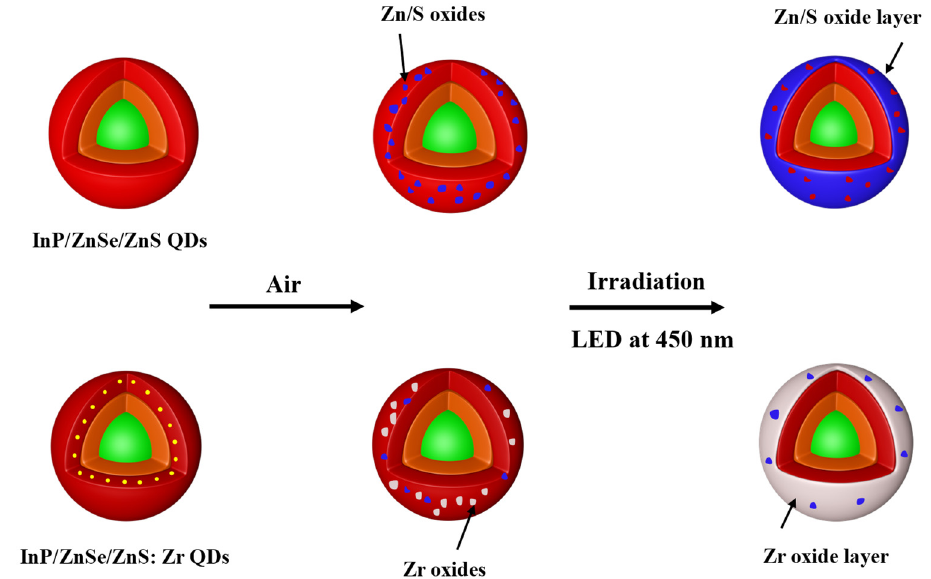
Figure 4. XPS of the ( A ) Zr3d region and ( B ) O1s region of InP/ZnSe/ZnS:Zr (S/Zr = 1:4) QDs before and after light irradiation.